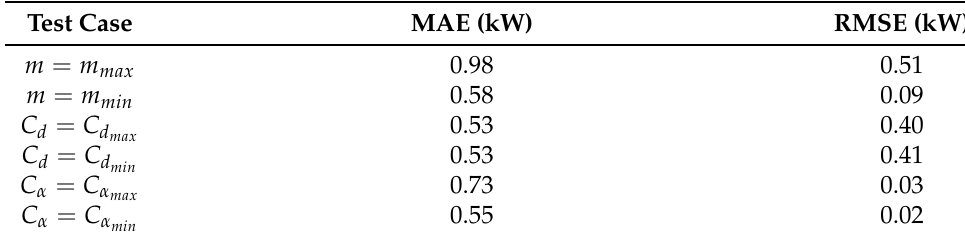
Table 12. MAE and RMSE for wheel power.